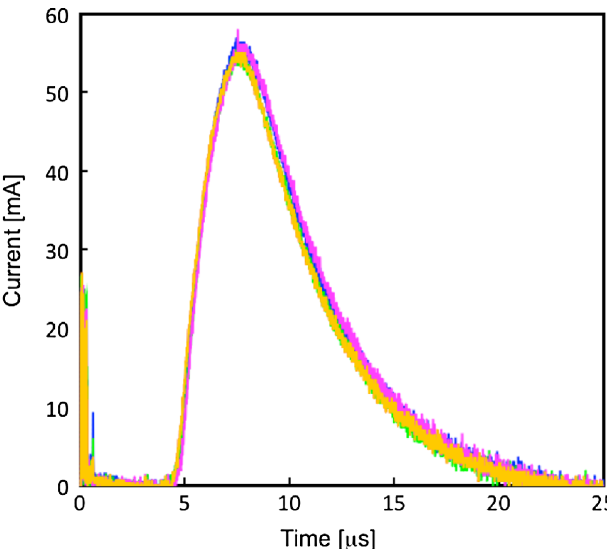
FIG. 41. Output current from channel 1 to output current from channel 2 (pickup voltage: 5.2 V; plasma input position: 6 mm; extraction voltage: 30 kV). The input current to channel 2 is